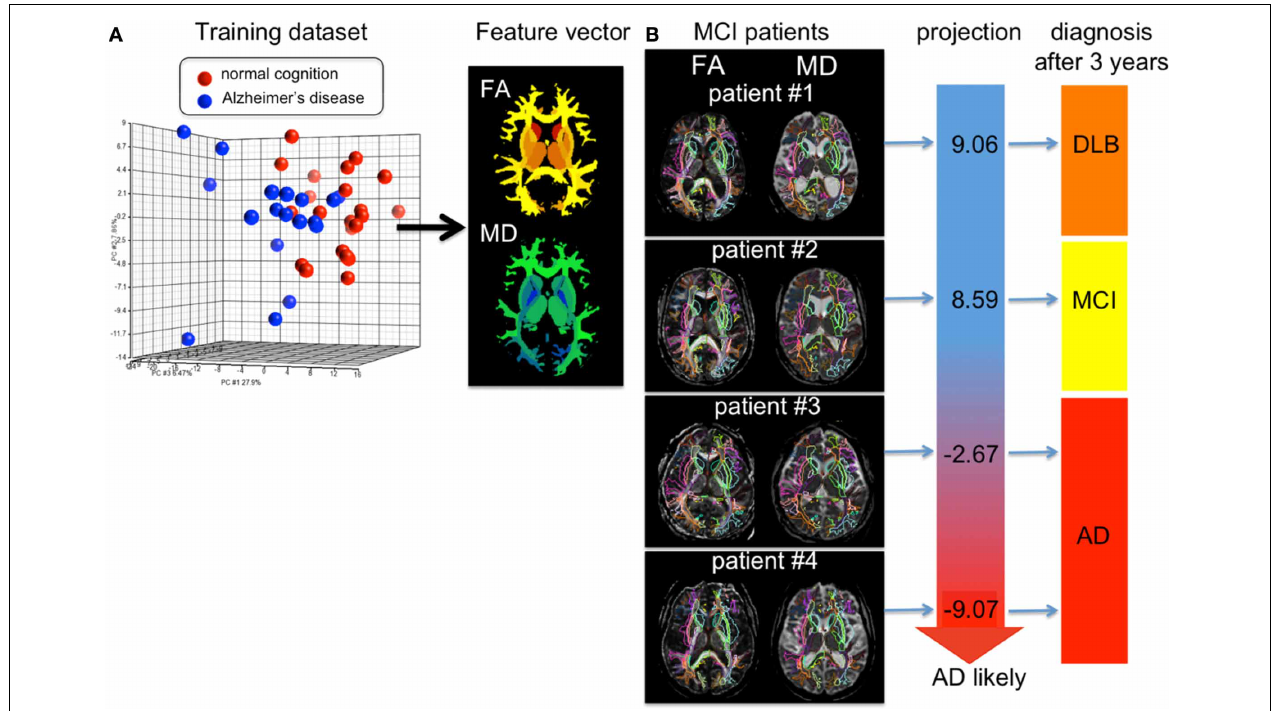
FIGURE 9 | (A) shows the result of PCA of the DTI derived measurements (FA = fractional anisotropy and MD = mean diffusivity) from 136 white matter areas and 12 deep gray matter structures. The first component was used as a diagnostic feature vector; the brighter area indicates more weighting to a degree of FA reduction and the cold brighter area indicate more weighting to a degree of MD increase to separate the AD group from the control group.